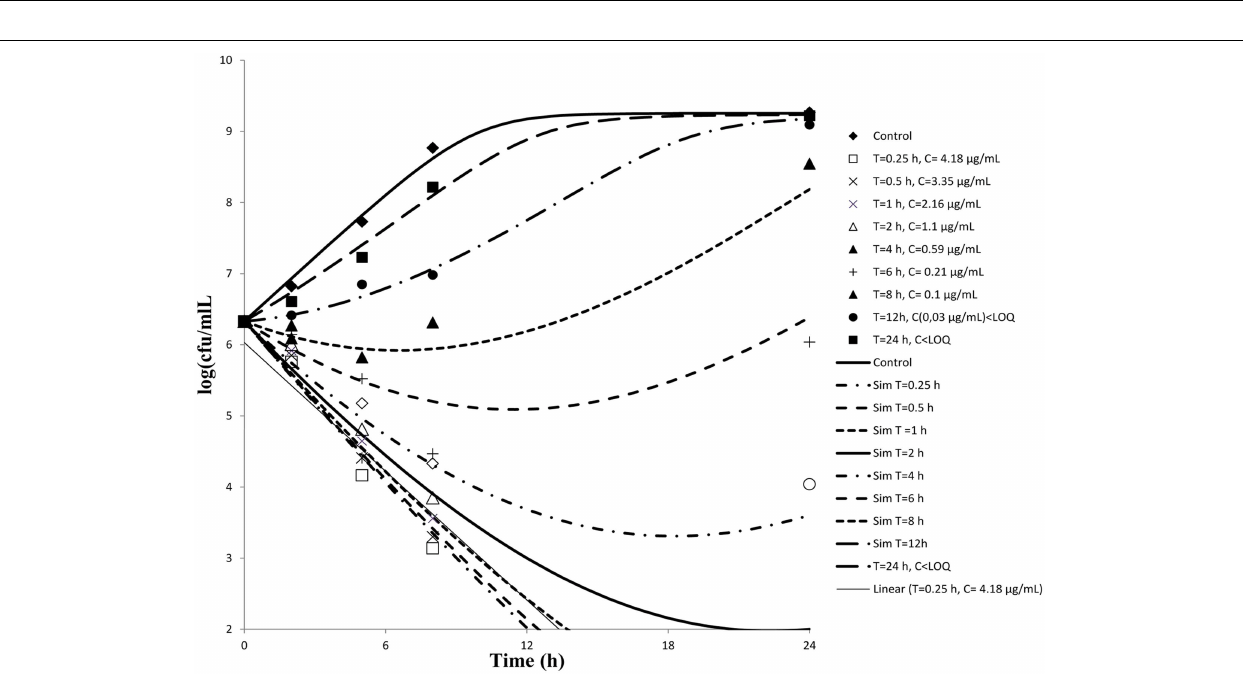
while a dose of 2 mg/kg lead to a net reduction of a factor of 10 after 12 h. Different dosage regimen for 3 days of treatment (1 mg/kg every 12 h, 1 mg/kg every 24 h and 2 mg/kg every 24 h, 2